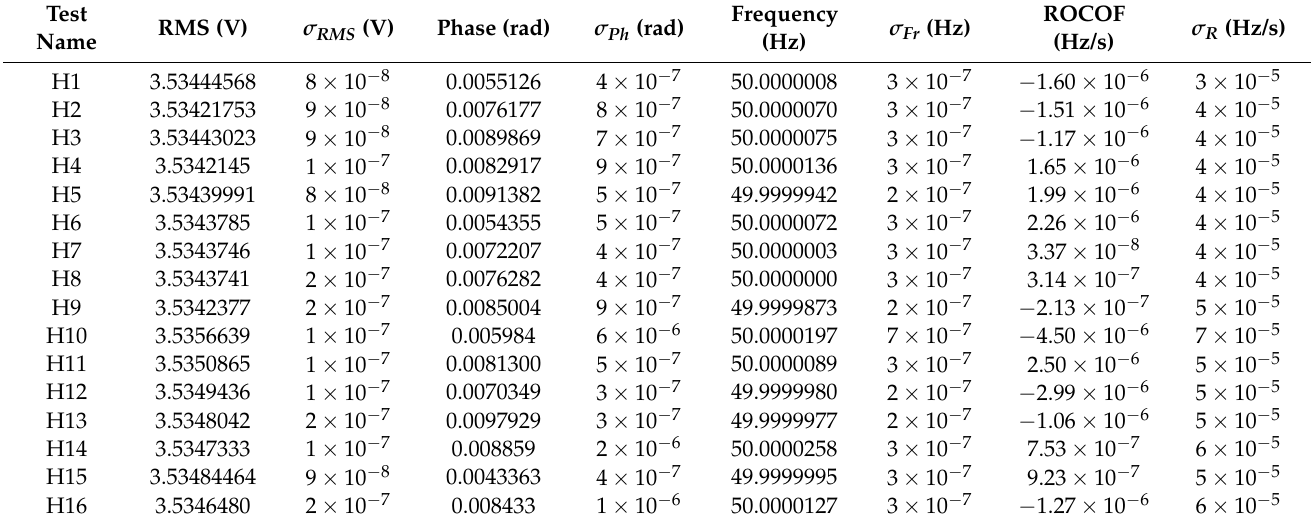
Table 17. Measurement results of the harmonic tests.